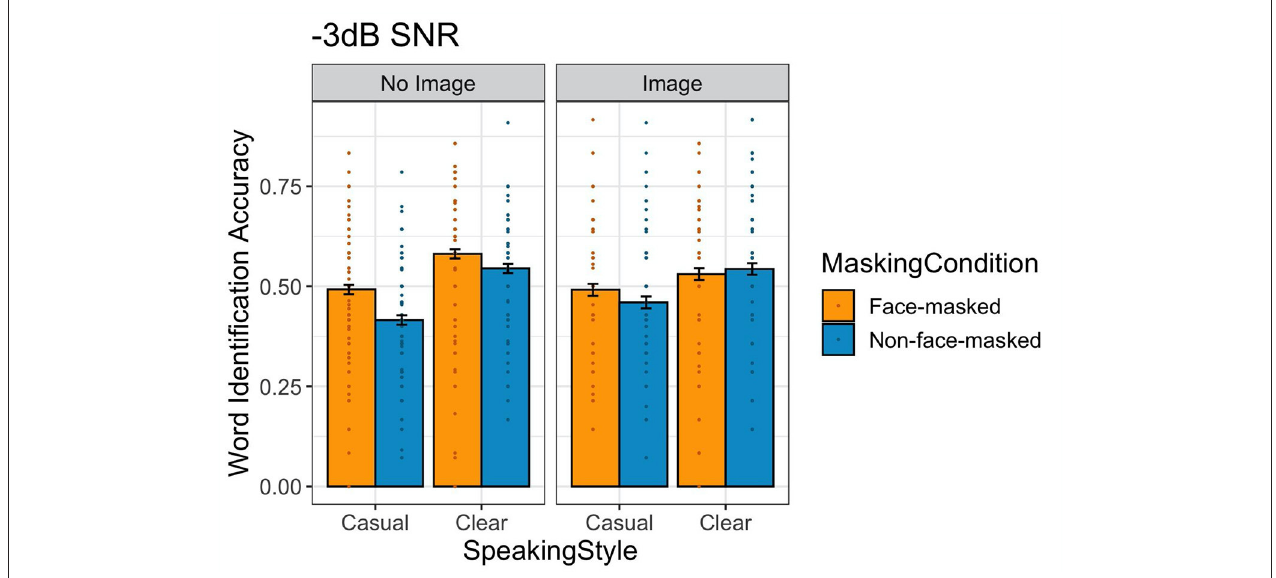
FIGURE 4 | (Color online) Target word identification accuracy for Experiment 2, − 3 dB SNR. The bars show the mean for each speech style, face-masking, and image condition. The error bars indicate standard errors of the mean. Individual points show mean accuracy for each participant across conditions.